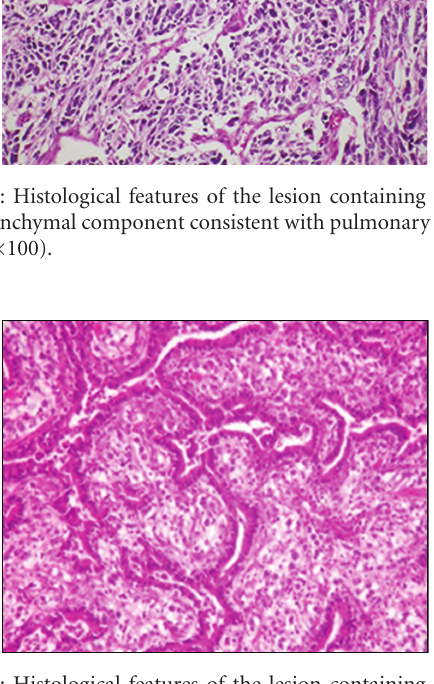
Figure 4: Histological features of the lesion containing epithelial and mesenchymal component consistent with pulmonary blastoma (H&E ×